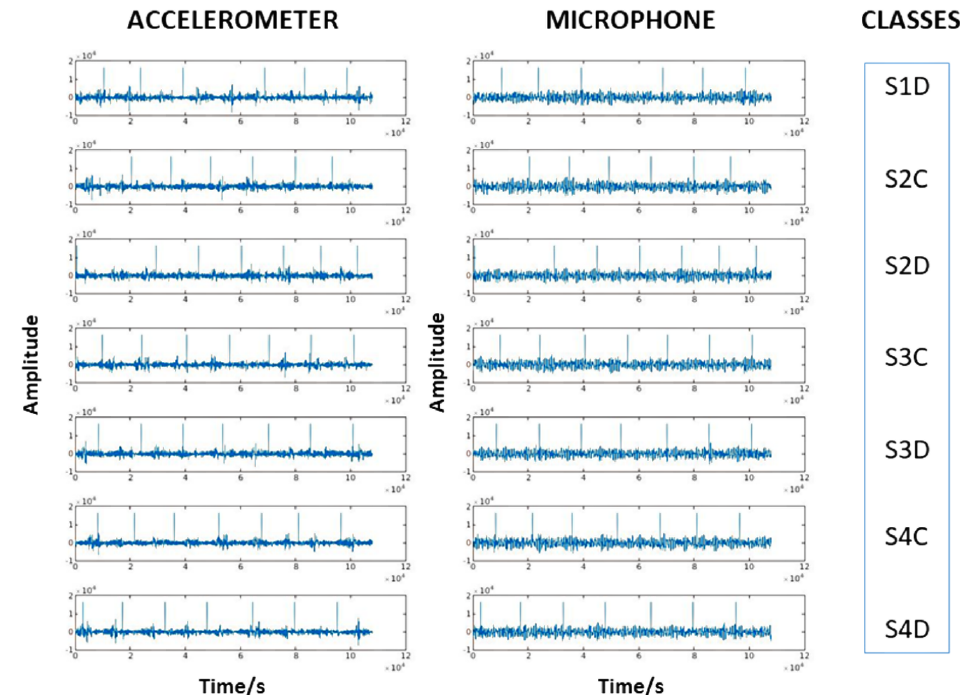
Figure 3. Sample of recorded accelerometer and microphone signals for each class.